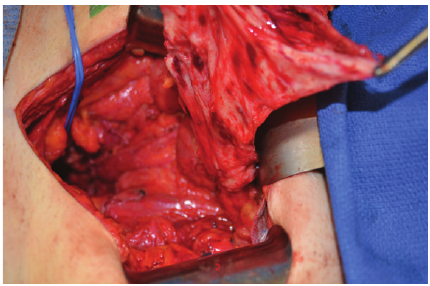
Figure 3: Seromuscular colon flap after mucosectomy with mesen- tery